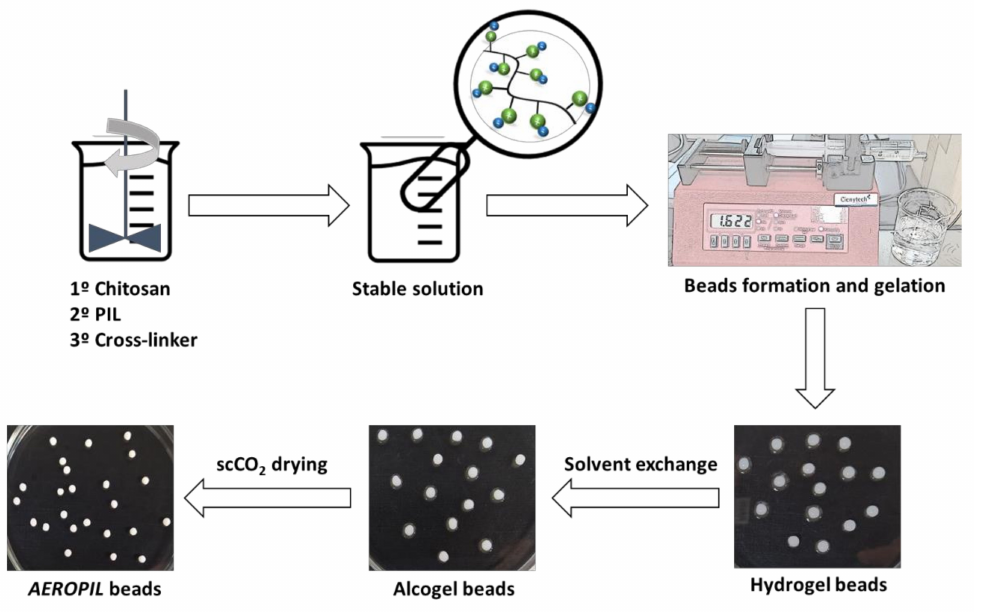
Figure 7. General scheme of AEROPIL beads preparation